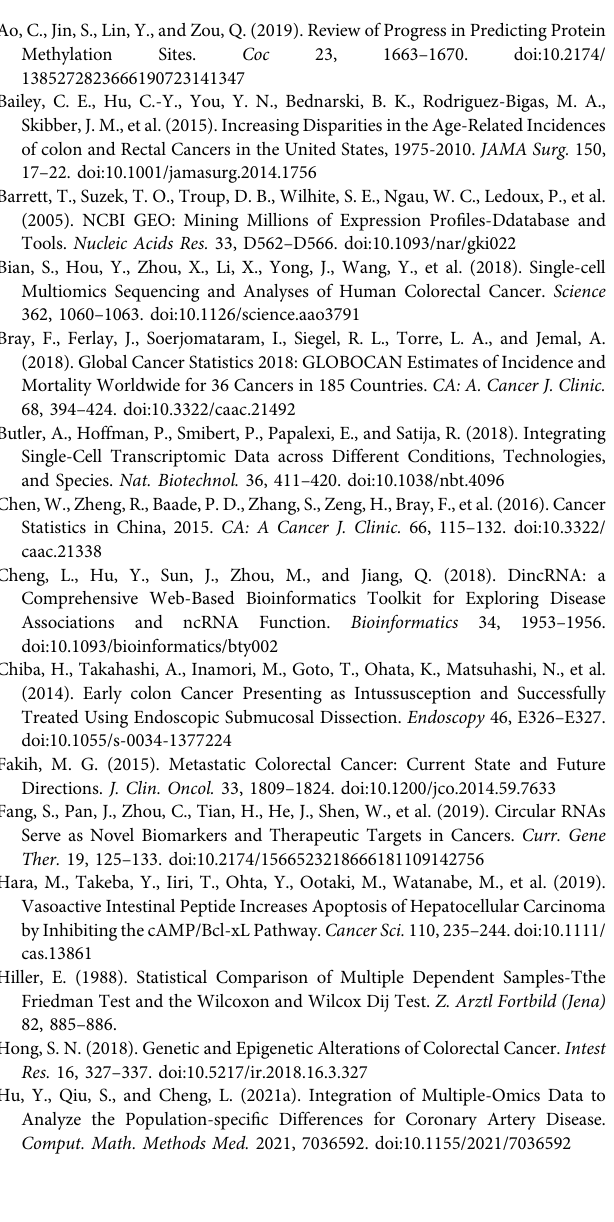
Supplementary Figure S4 | The results of biological process enrichment analysis for upregulated methylated genes in colon cancer and subtypes. Supplementary Figure S5 | The results of biological process enrichment analysis for downregulated methylated genes in colon cancer and subtypes. Supplementary Figure S6 | The results of KEGG pathway enrichment analysis for upregulated methylated genes in colon cancer and subtypes. Supplementary Figure S7 | The results of biological process enrichment analysis forupregulatedexpressed and downregulated methylate genesincoloncancerand subtypes. Supplementary Figure S8 | The results of biological process enrichment analysis for downregulated expressed and upregulated methylated genes in colon cancer and